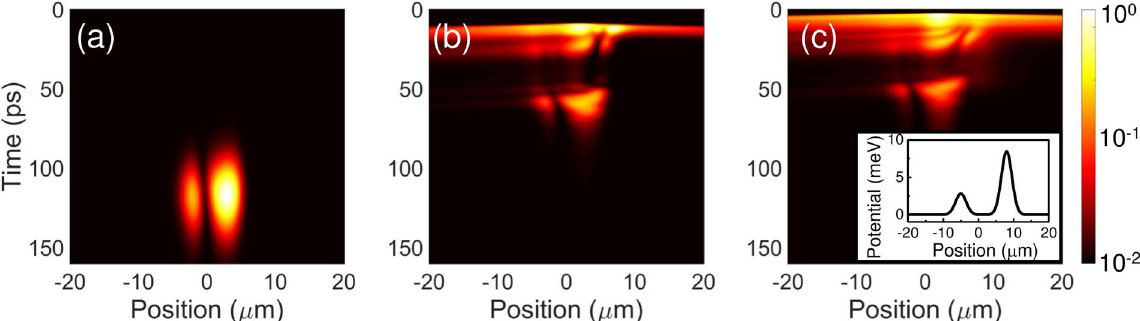
Figure 3. Simulation results with disorder potential. Simulation results of a time-resolved propagation of polariton condensate after a pump pulse strength of ( a ) 1.5 P 0 , ( b ) 8 P 0 , ( c ) 15 P 0 . P 0 stands for pumping amplitude to observe first condensation pulse. Simulation results are convolved with a streak camera system response function to emulate the experimental recordings. The pseudo-color scale is logarithmic and the intensities are normalized to the maximal value in each case. The chosen disorder potential is presented as an inset of ( c